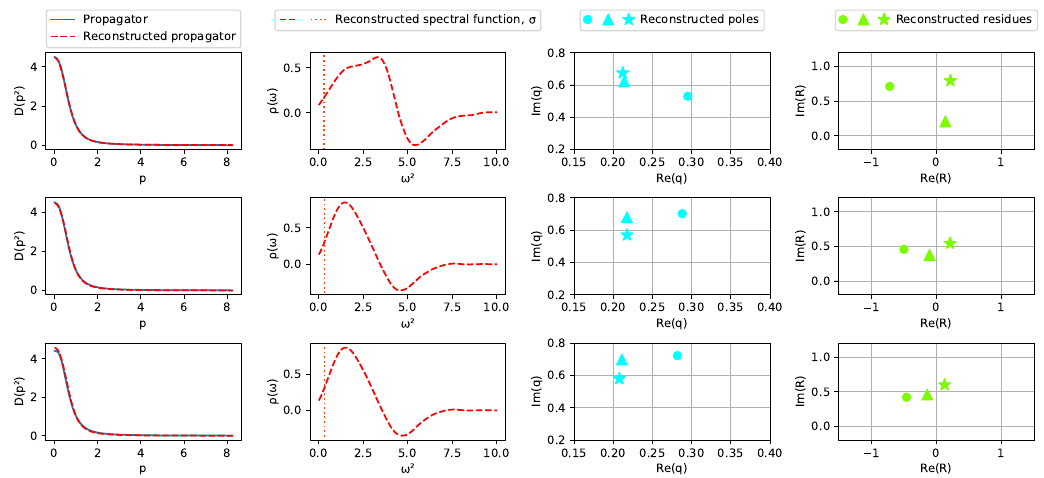
Figure 5: A selection of reconstructed spectral functions from 18,000 gluon propa- gators generated from Monte Carlo sampling (80 4 configuration), sorted according to their MAE: the best (top row), the median, and the worst (bottom